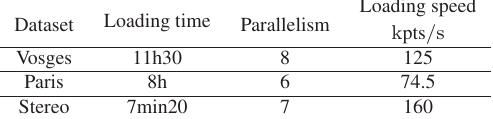
Table 2: Loading time for each point cloud data set.